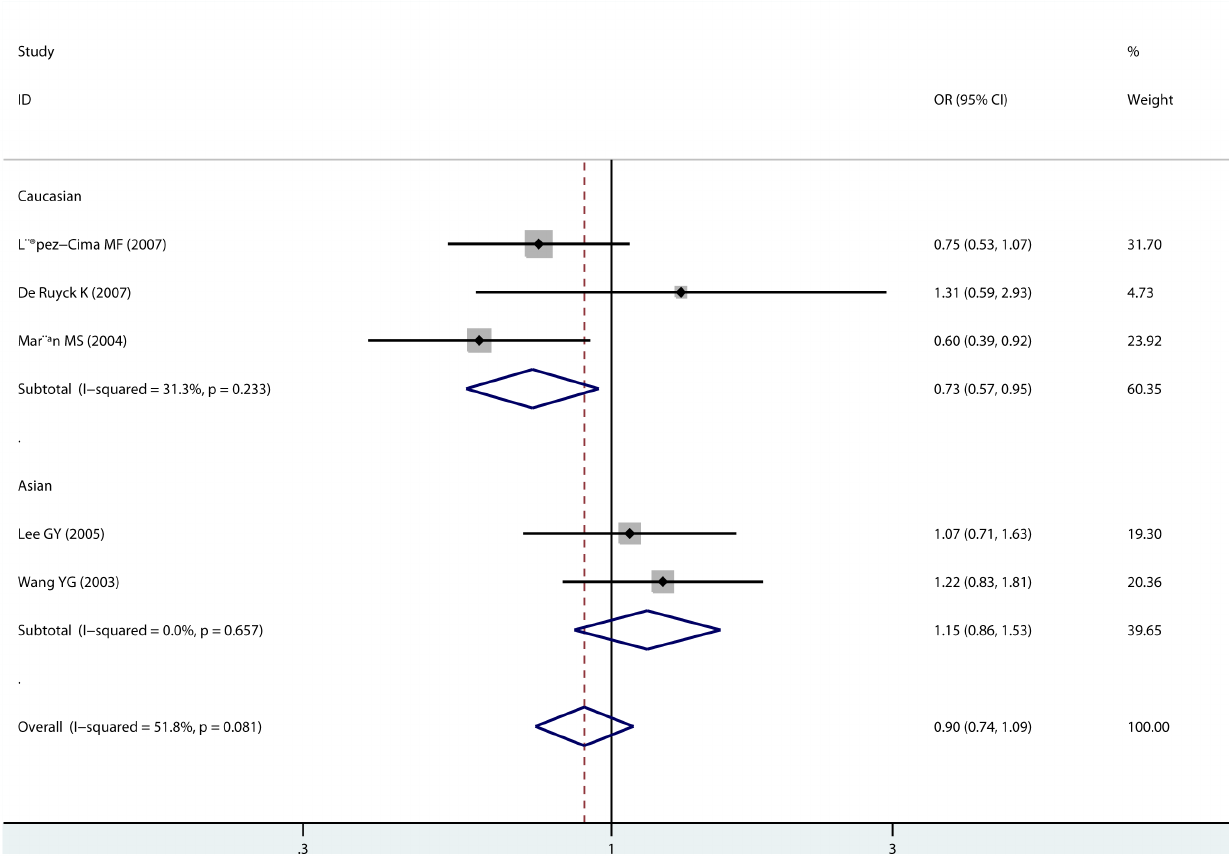
Figure 4. Forrest plot of XPC PAT polymorphism ( 2 / 2 vs. + / + ) by ethnicity.